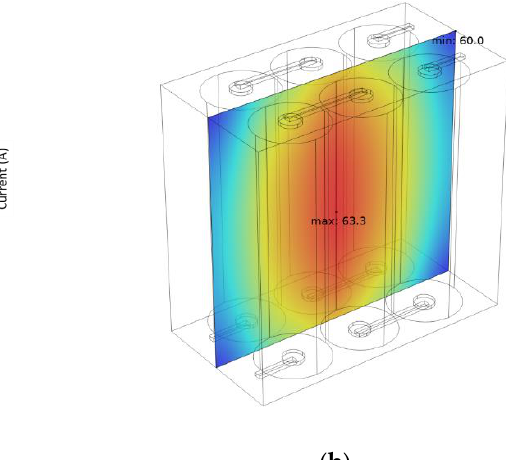
Figure 13. Thermal distribution in plane and cross-plane of the GNP layer.